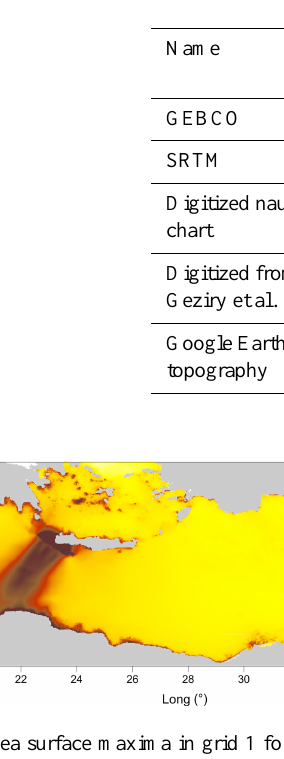
Table 2. Topo-bathymetric data sets used to build grids 1 to 4 for tsunami simulations.